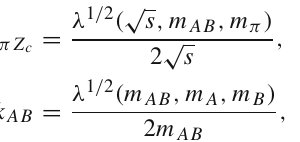
Fig. 1 Background ( a ) and rescattering ( b ) contributions for the pro- duction of the two-meson AB channel rest frame of π + A + B at energy are given